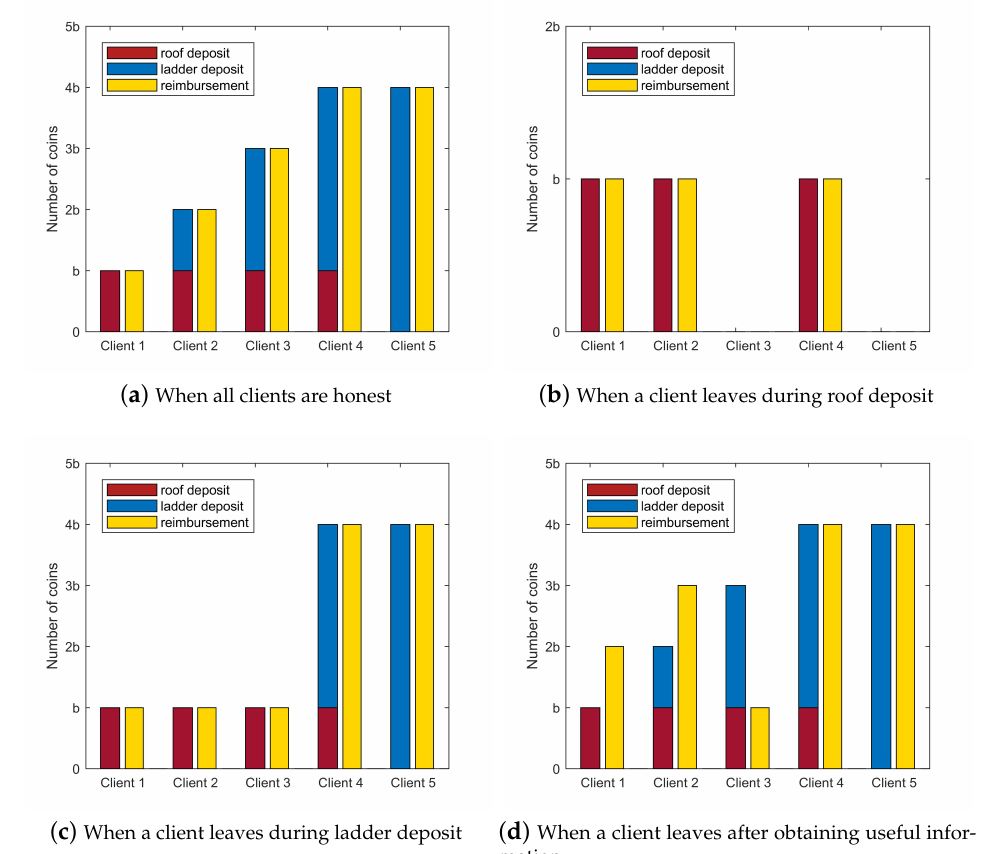
Figure 8. The circulation of digital currencies when there are 5 clients participating in